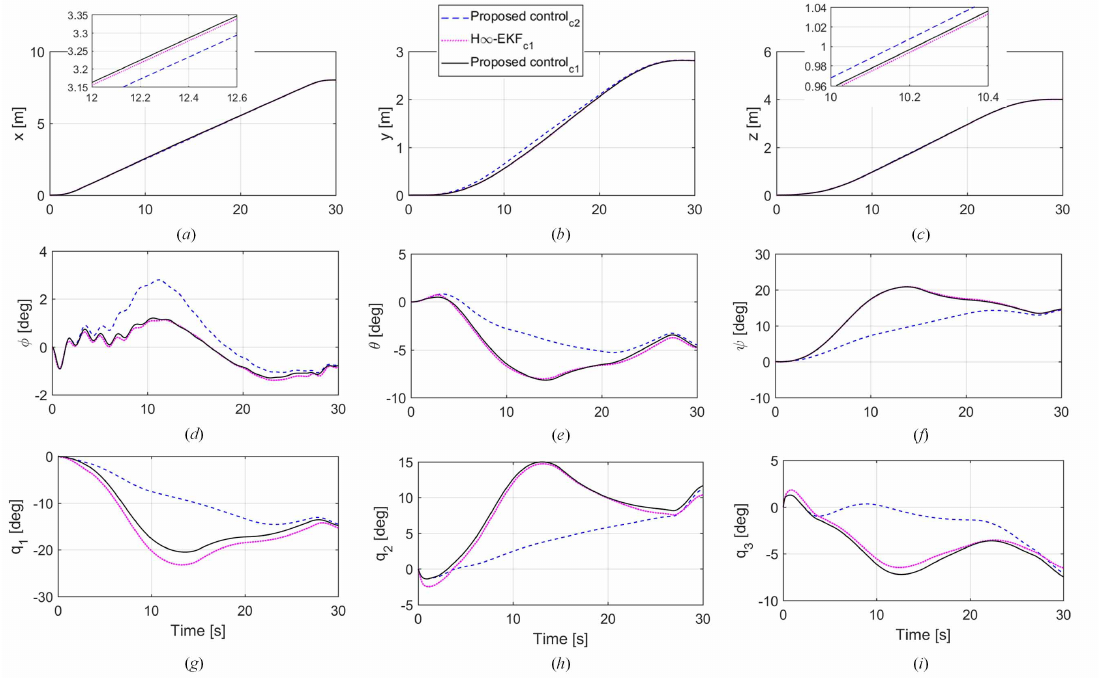
Figure 10. Joint-space positions for the straight line trajectory. ( a ) X position, ( b ) y position, ( c ) z